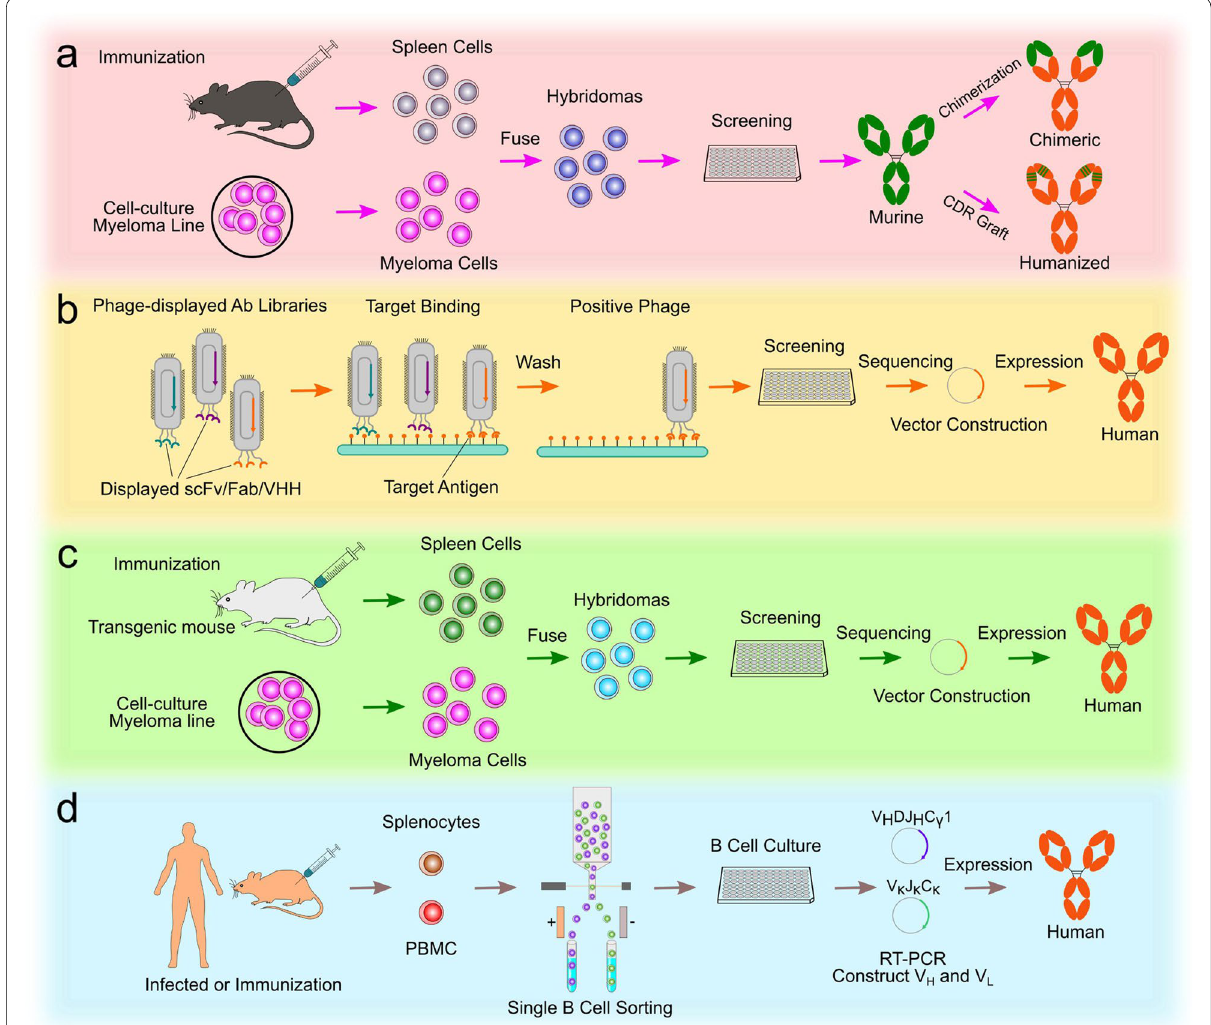
Fig. 6 Technologies for the development of therapeutic antibodies. a Mouse hybridoma technique. Mice are immunized with desired antigens to induce high immune titers. Myeloma cells and harvested splenocytes are fused to produce hybridomas that persist in secreting antibodies. A chimeric or humanized antibody is then created after the screening has been completed. b Phage display. A library of human antibodies is constructed and fused to the gene that encodes the pIII coat protein on the surface of the phage. After binding the target antigen of bio-panning, positive phage clones are screened and then DNA sequences are analyzed to construct and express human IgG. c Transgenic mouse. The mice are genetically engineered to contain one or more human immunoglobulin loci which are capable of undergoing gene rearrangement and gene conversion in the transgenic mice to produce diversified human immunoglobulins. Then the fully human antibody screen approach is similar to the mouse hybridoma technique. d The single B-cell technique. From infected or immunization donors, PBMCs are prepared for the isolation of suitable B cells by flow cytometry. Following the RT-PCR, VH and VL information of each B cell informs the generation of human